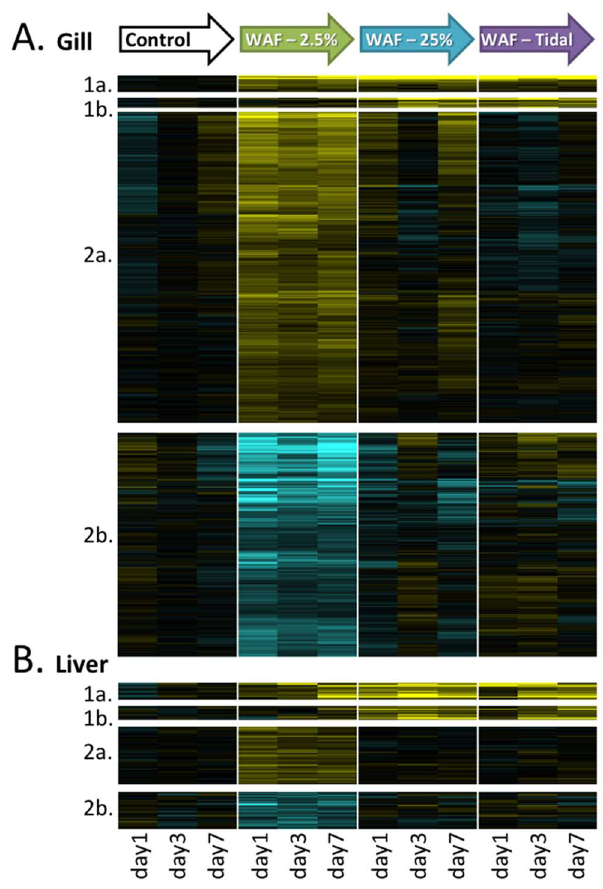
Figure 3. Patterns of expression for significantly WAF-respon- sive genes across treatments and time points for gill (A) and liver (B). Each row represents a gene, and columns represent consecutive sampling times (1 day, 3 days, 7 days) within a WAF treatment. Cell color indicates an up regulation (yellow) or down- regulation (blue) compared to the control treatment. Genes are grouped by patterns of co-regulation. Four patterns of co-regulation were observed relative to the control for both tissues, including up- regulated for all WAF concentrations (cluster 1a), up-regulated for the high and tidal concentrations only (cluster 1b), up-regulated for the low concentration only (cluster 2a), and down-regulated for the low concentration only (cluster 2b). Scale indicates fold-level of up-